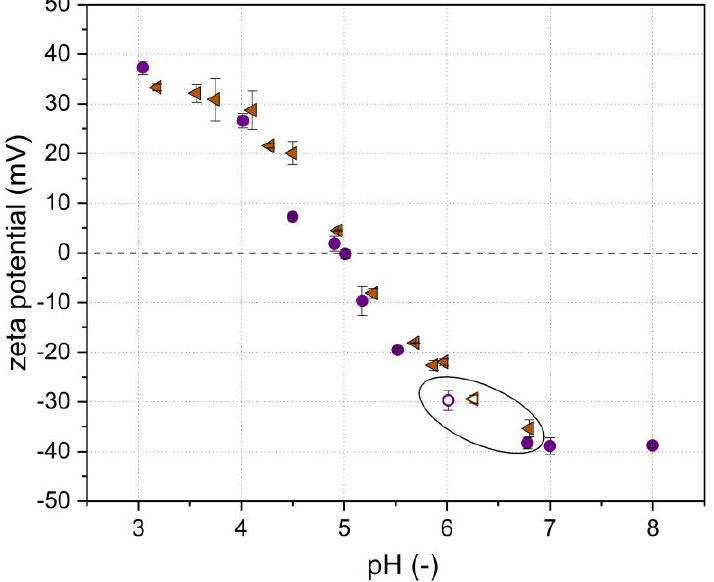
Figure A2. Zeta potential of purified β -Lg particles (c = 8.2 g L − 1 ) obtained at different heating pH values ( ● pH 5.8, ◀ pH 6.2) as a function of the pH. Error bars indicate standard deviation.